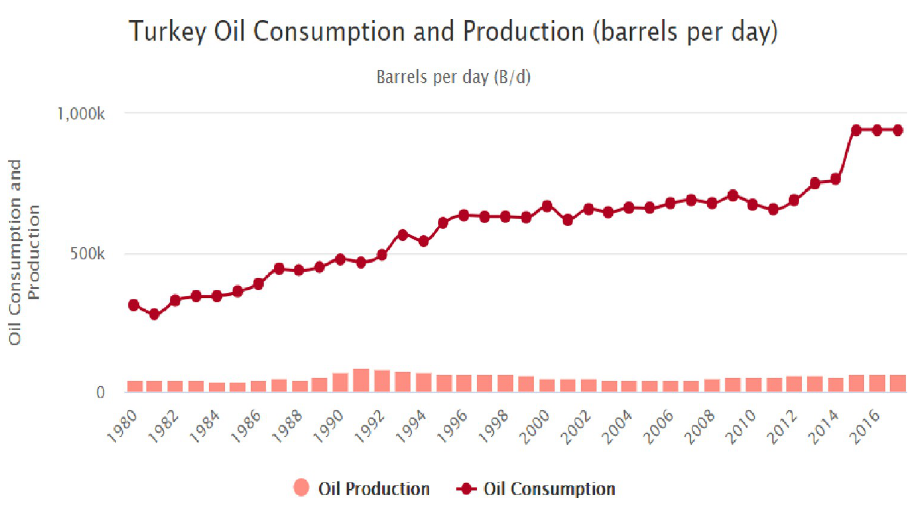
Fig 1. Oil production and consumption for 1980 to 2016 period in Turkey. Source: world meters.